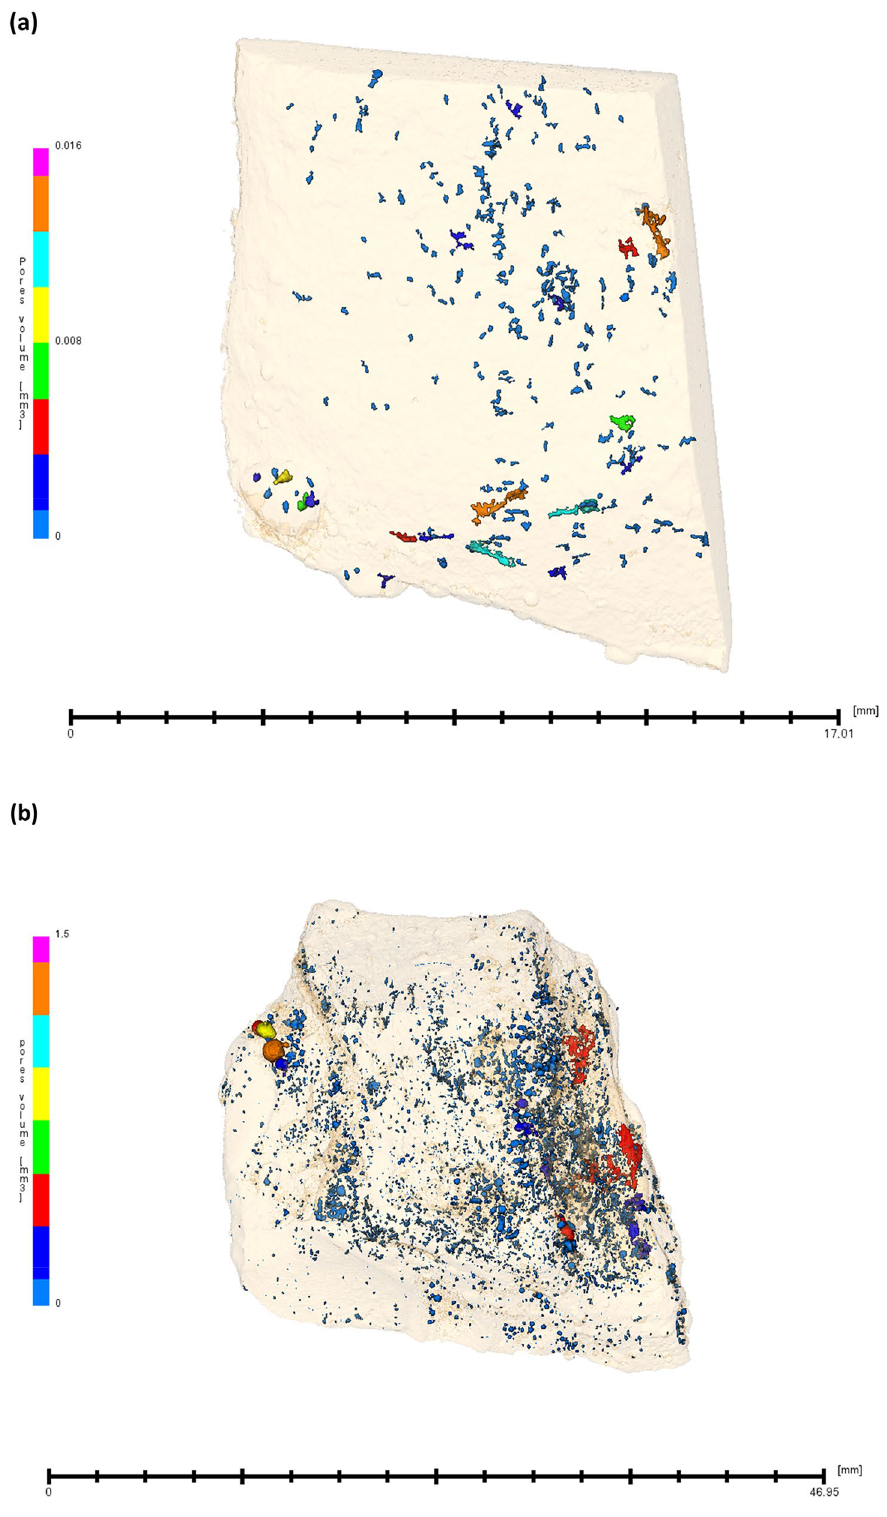
Figure 6. Neutron tomographic images depicting the volume of the pores that are formed on the iron made through ancient Indian metallurgical methods in ( a ) un-hammered iron ( b ) hammered (forged)